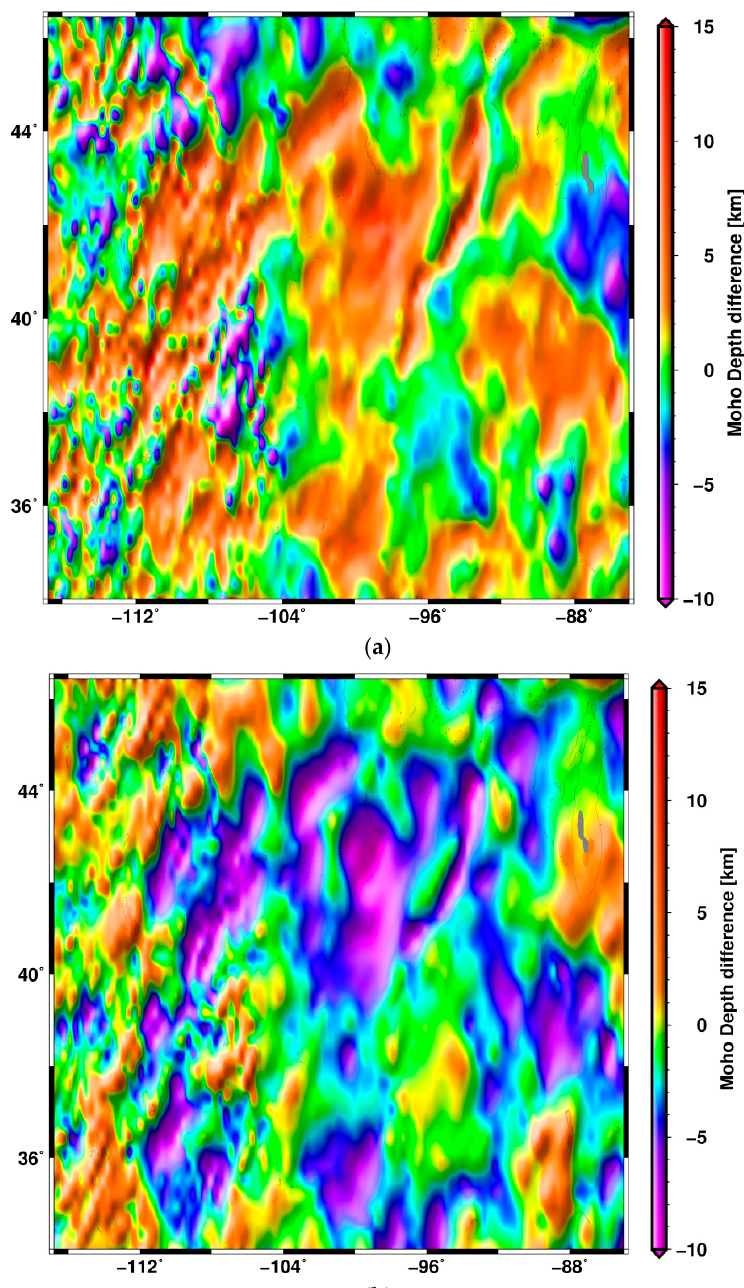
Figure 9. The Moho depth differences between ( a ) the HRCM Butterworth filter solution and the United States Moho model [32] and ( b ) the HRCM spectral combination solution and the United States Moho model [32]. Unit: km.